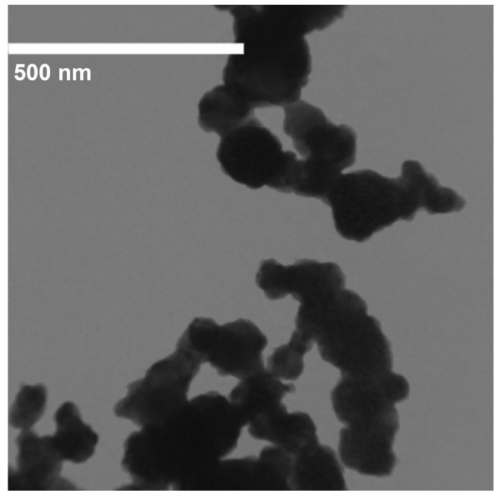
Figure 2. TEM image of MoS 2 nanoparticles [52]. Table 1. Chemical composition of SKD 11 steel (According to JIS G4404:1983).